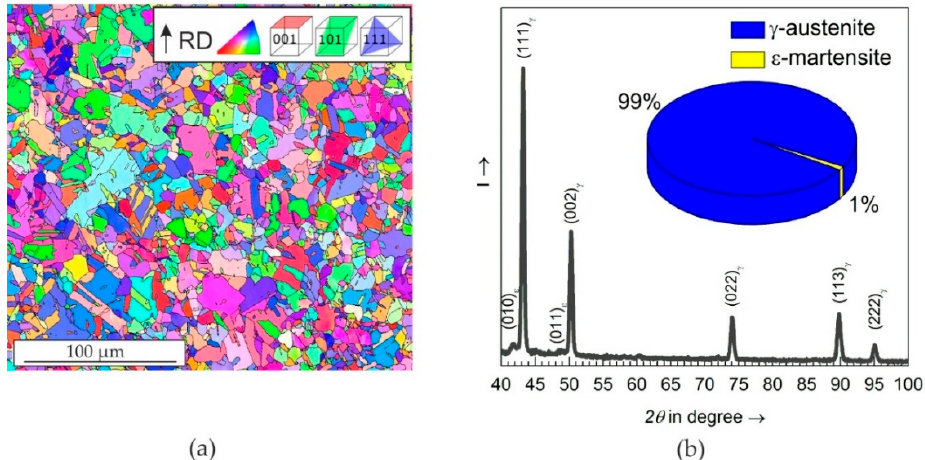
Figure 2. Microstructure of HSD ® 600 TWIP steel in polished state: ( a ) inverse pole figure of Electron Backscatter Diffraction (EBSD) (RD: rolling direction); ( b ) X-Ray Diffraction (XRD) and phase fractions in vol. %.